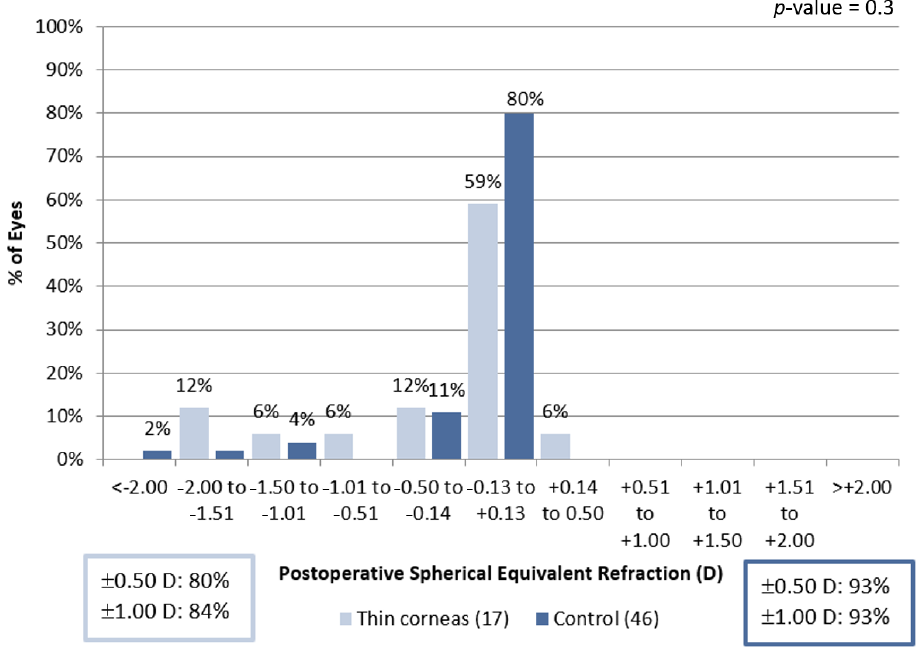
Figure 4. Spherical equivalent refractive accuracy at 6 months. One month after the procedure, spherical equivalent stability (Figure 5) was −0 .45 ± 1.01 D in the eyes of patients from the “thin corneas group” and − 0.11 ± 0.45 D in the eyes − 0.42 ± 1.03 and − 0.09 ± 0.33 D in patients from the “thin corneas” and control groups, respectively ( p > 0.05). There were no significant differences in spherical equivalent at 6 months ( p >